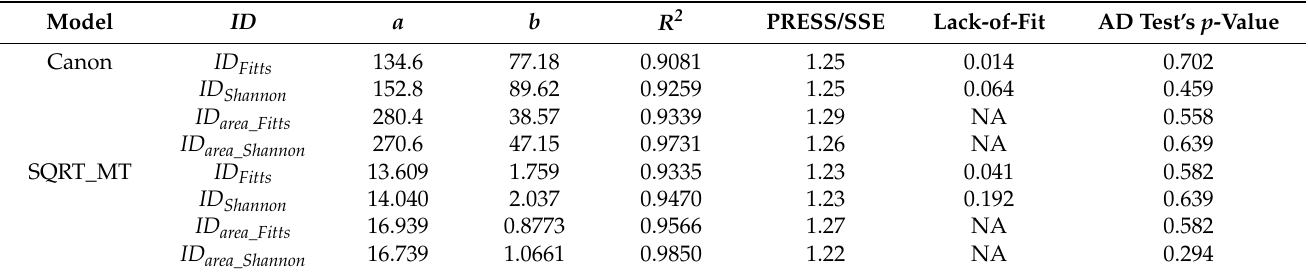
Table 13. Regression analysis for the amplitude of 1024 pixels. ID area_Shannon had the best R-square and PRESS in both the Canon and SQRT_MT